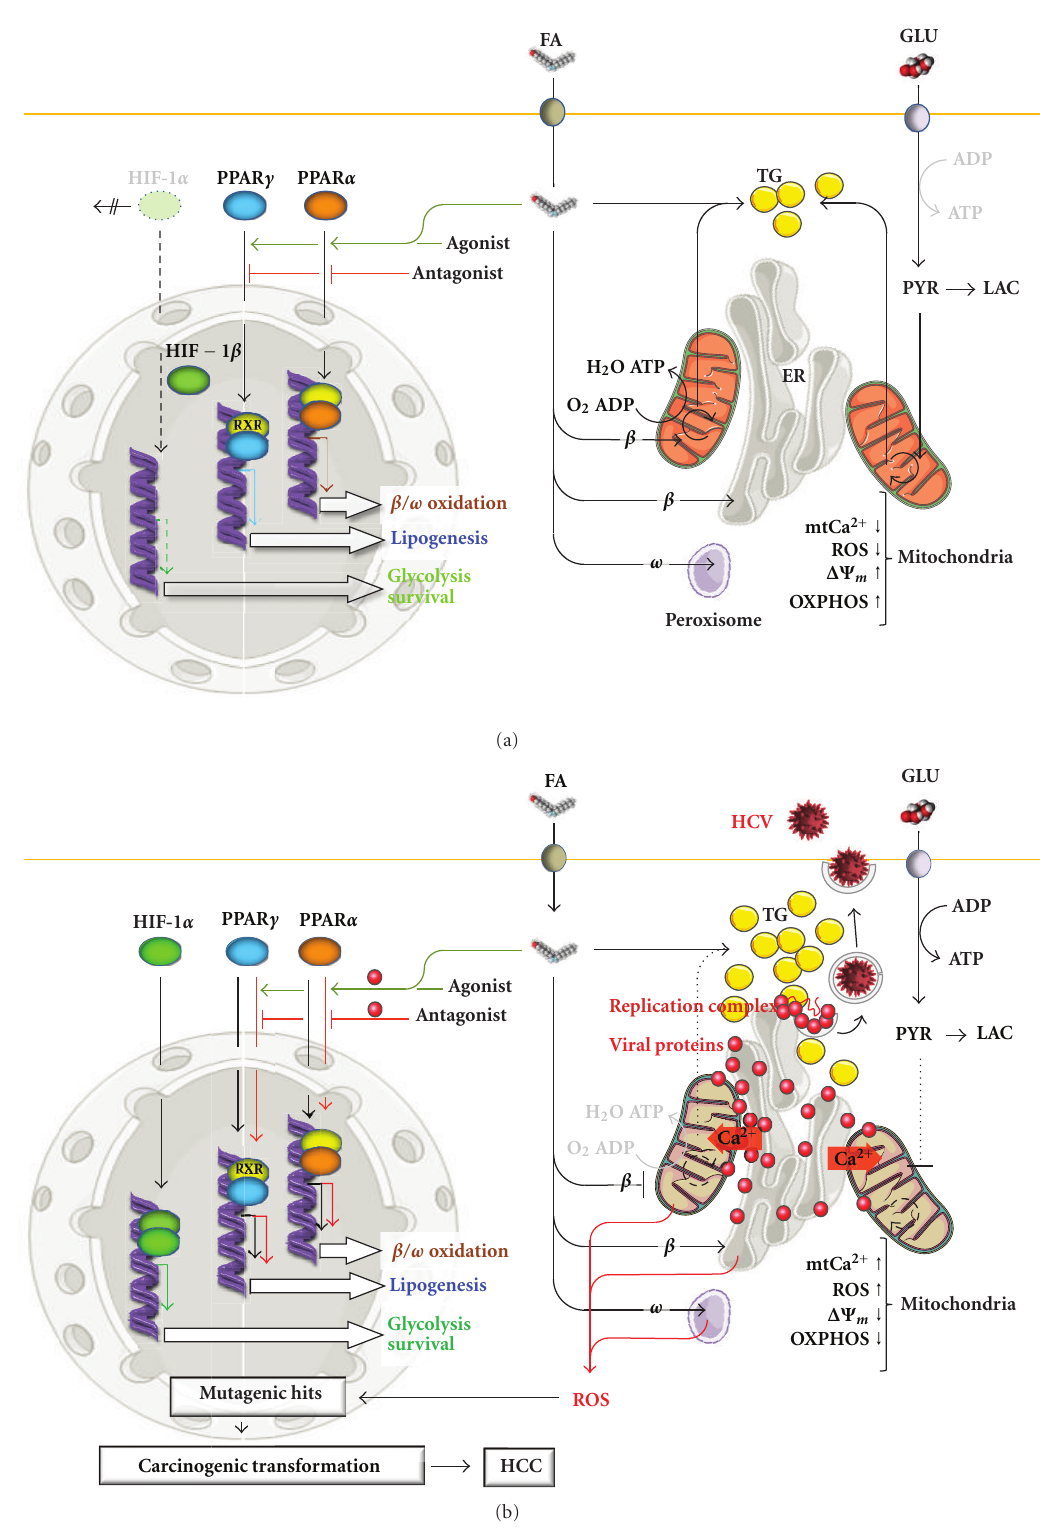
Figure 1: Schematic representation of the interplay between deregulation of the PPARs pathways and the HCV-mediated dysfunctions of mitochondria. (a) Normal noninfected condition. (b) HCV-infected condition Glu, glucose; Pyr, pyruvate; Lac, lactate; HIF-1 β , hypoxia inducible factor 1 β ; RXR, retinoid X